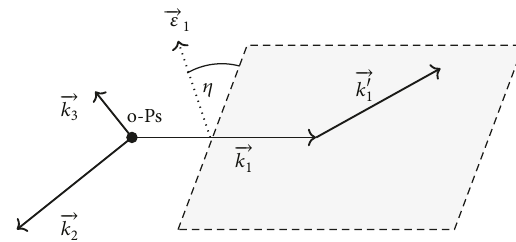
Figure 5: Scheme of estimation of polarization vector for a photon produced in o-Ps 󳨀→ 3 𝛾 at J-PET. Photon of momentum tered in one of the detection modules and a secondary interactionof the scattering product The most probable angle 𝜂 between the polarization vector the scattering plane spanned by